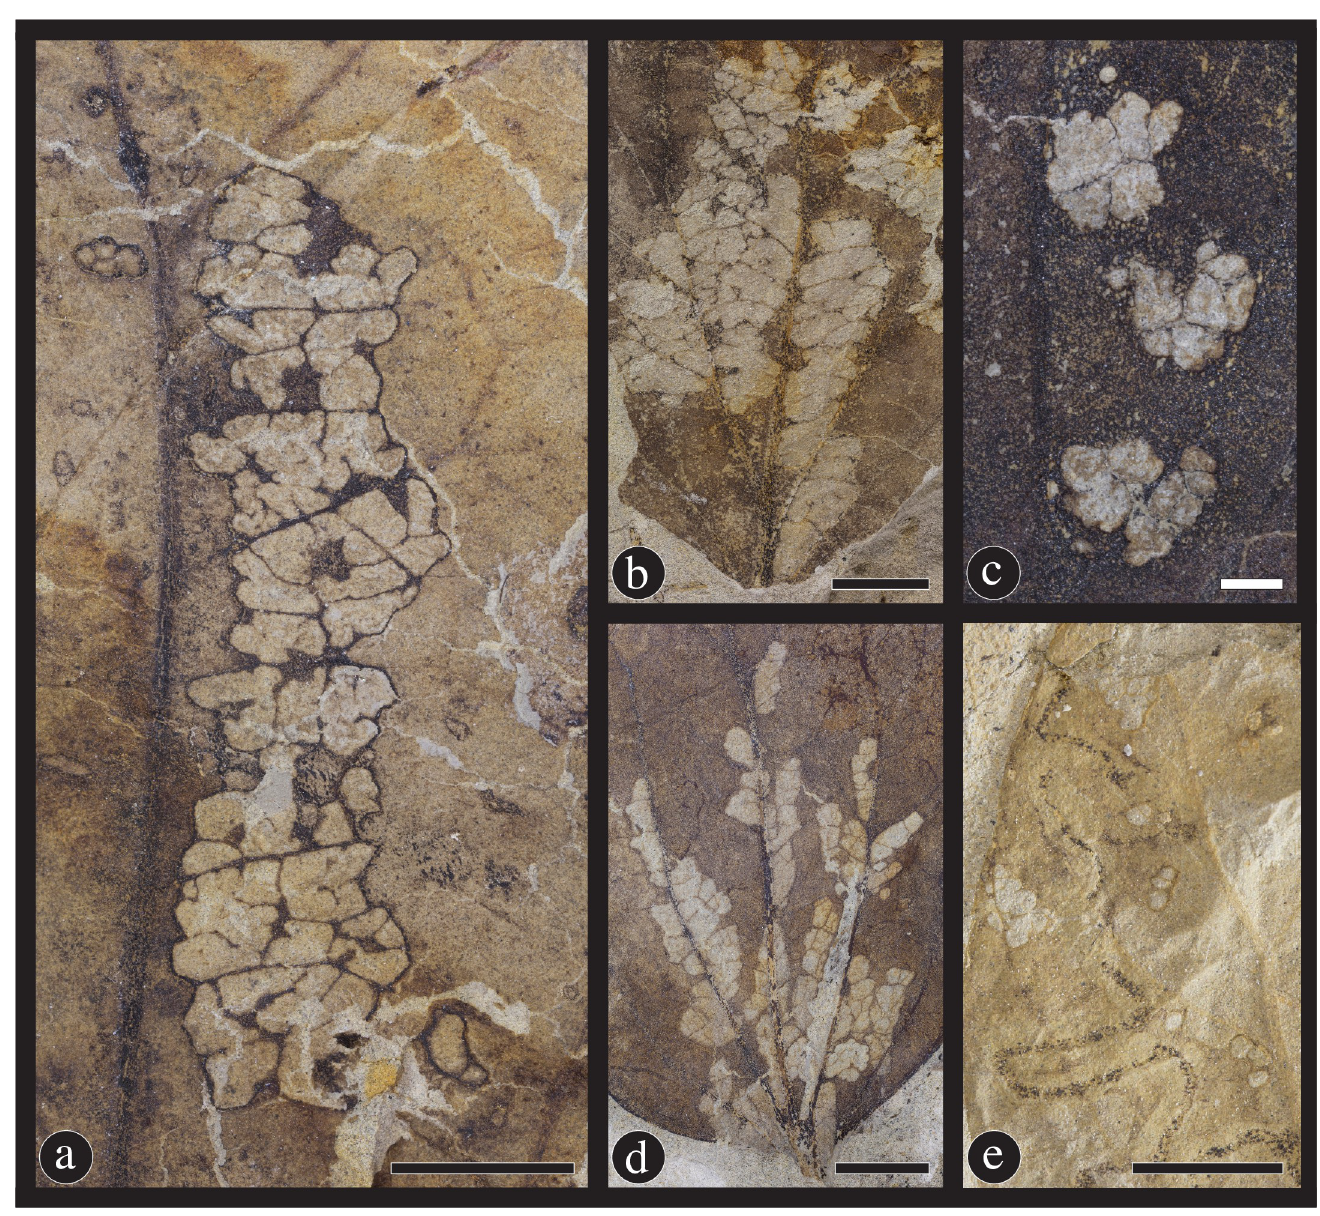
Fig 10. Skeletonization damage types on Catula gettyi . (A) DT22; Skeletonization which follows a primary vein (DMNH 41565); (B) DT19; Broad swaths of skeletonized tissue in a rectilinear shape (DMNH 41568); (C) DT24; Circular areas of skeletonization adjacent to the primary vein (DMNH 41578); (D) DT61; Elongate areas of skeletonization adjoining primary and secondary venation (DMNH 41591); and (E) DT16; Unadorned and common areas of tissue removal between veins (DMNH 41594). Black scale bars = 5 mm; white scale bars = 1 mm.